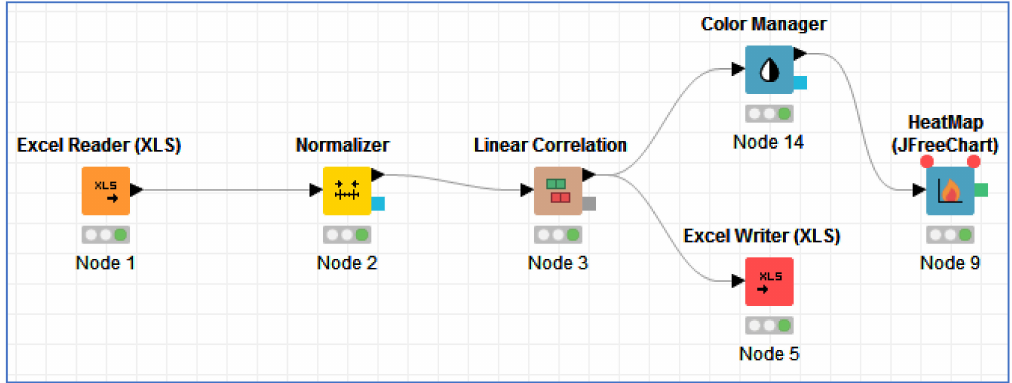
Figure 8. Workflow of Linear Correlation in KNIME